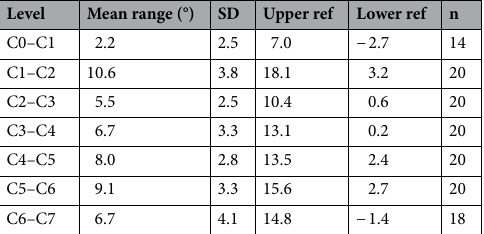
Table 1. Intervertebral